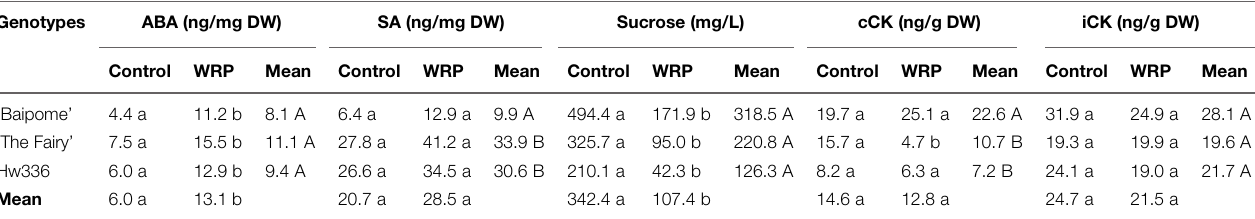
TABLE 3 | Abscisic acid (ABA), salicylic acid (SA), sucrose, conjugated cytokinins (cCK), and intermediate cytokinins (iCK) mean contents of three genotypes (‘Baipome,’ ‘The Fairy,’ and Hw336) determined in control plants and treated-plants during water restriction periods (WRPs). Genotypes